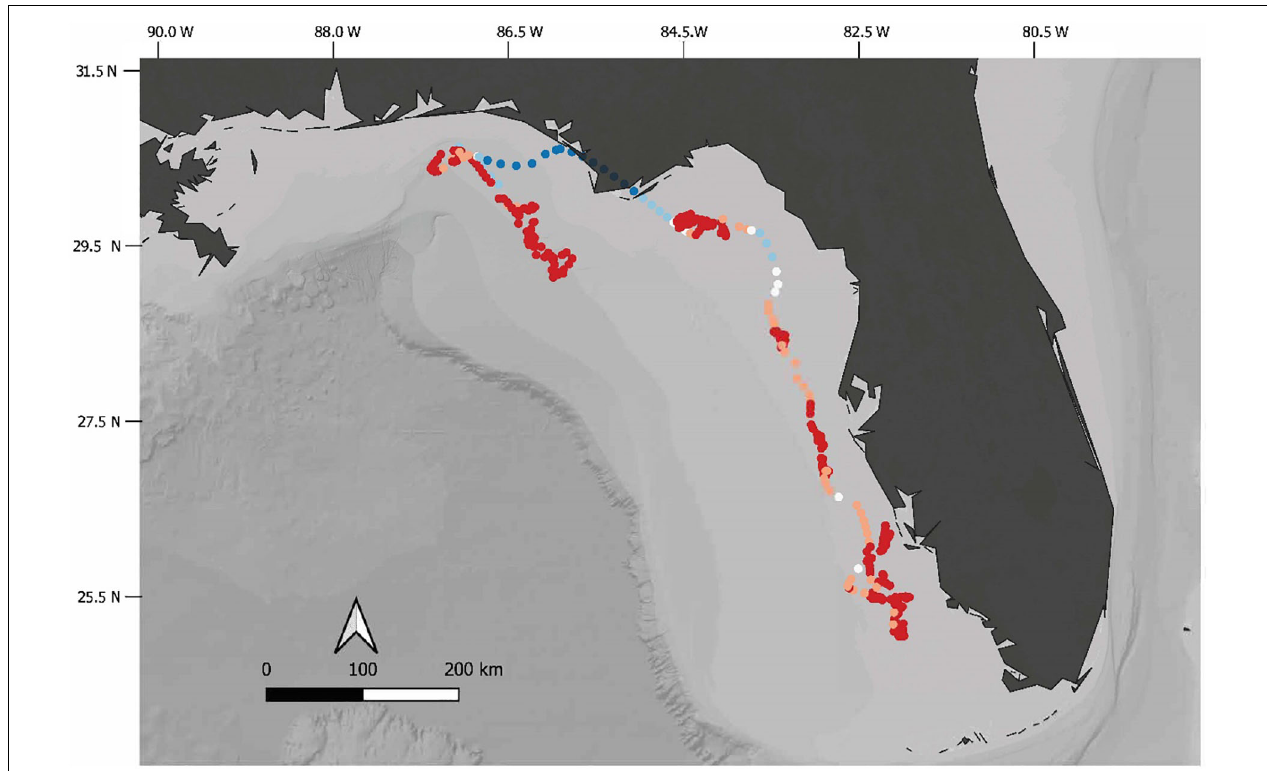
FIGURE 4 | Track and behavior of turtle 140166. Red represents foraging, blue represents migration, and orange/white/light blue represents searching/foraging.